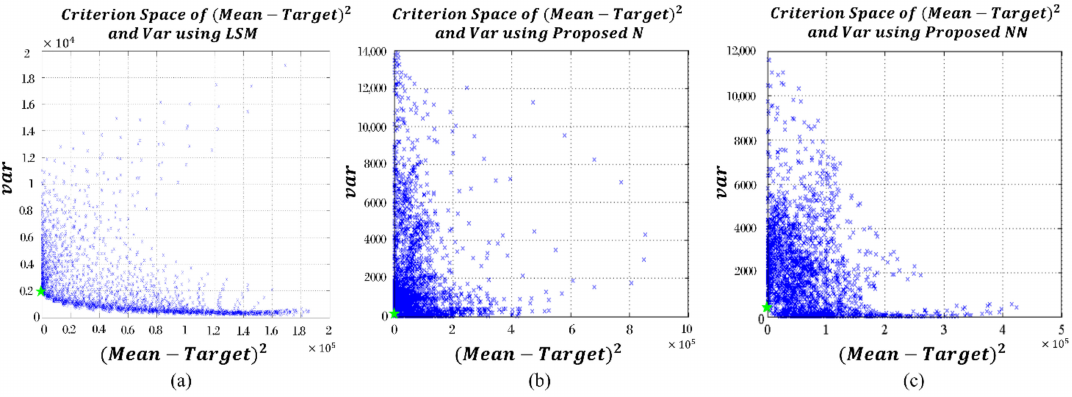
Figure 7. A green cross marks the optimal settings in each figure.